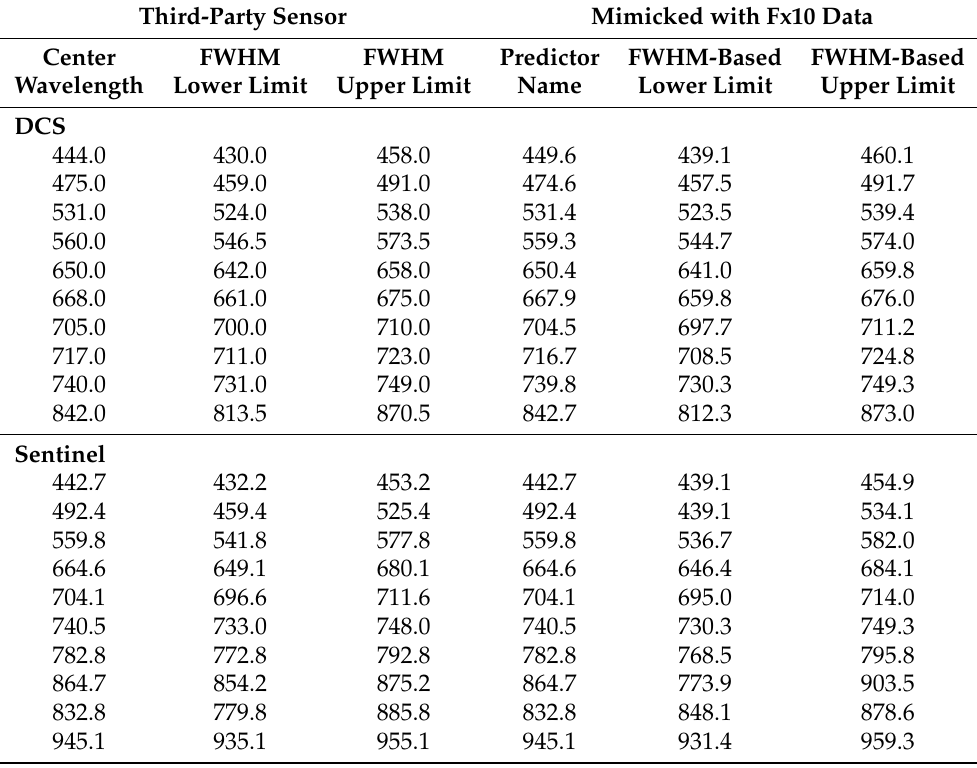
Table 2. Spectral specifications of the third-party sensor systems and the corresponding mimicked predictors (the unit of all values is nm). For Sentinel, three bands with wavelengths above 1000nm could not be